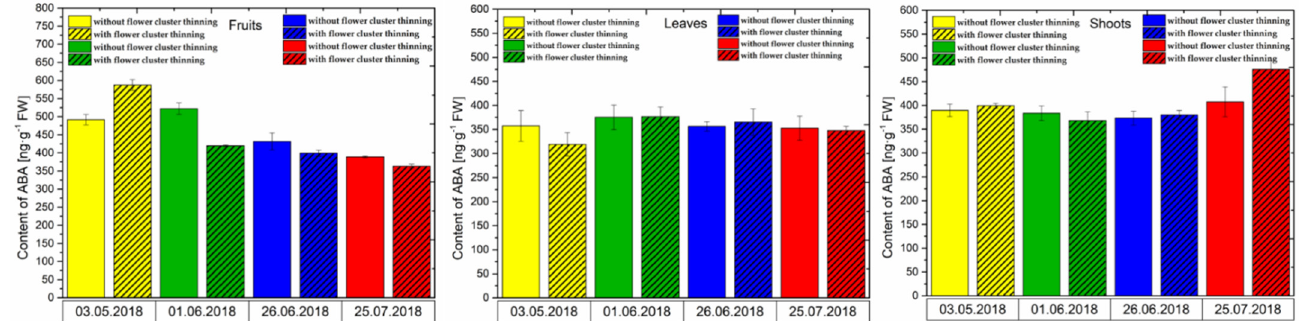
Figure 5. Concentration of ABA in Organs of Pistachio Trees With or Without Flower Cluster Thinning Application.